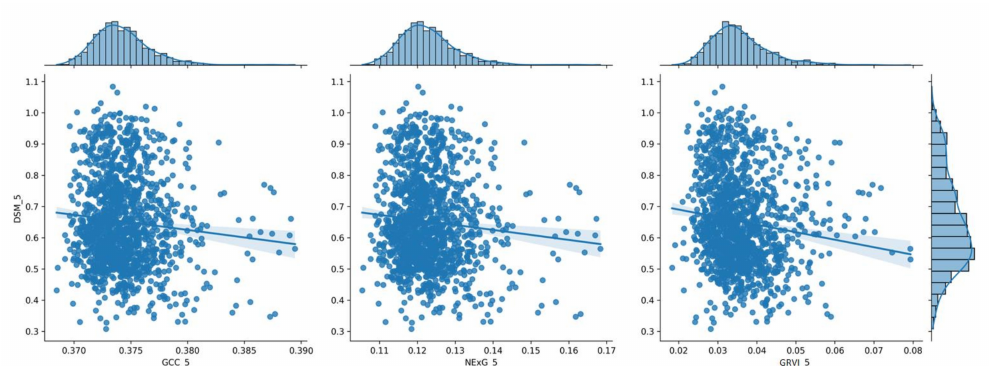
Figure 10. The distribution of the three (3) vegetation index values for the 4th measurement (80 DAS), shown in a histogram in relation to the corresponding DSM values.